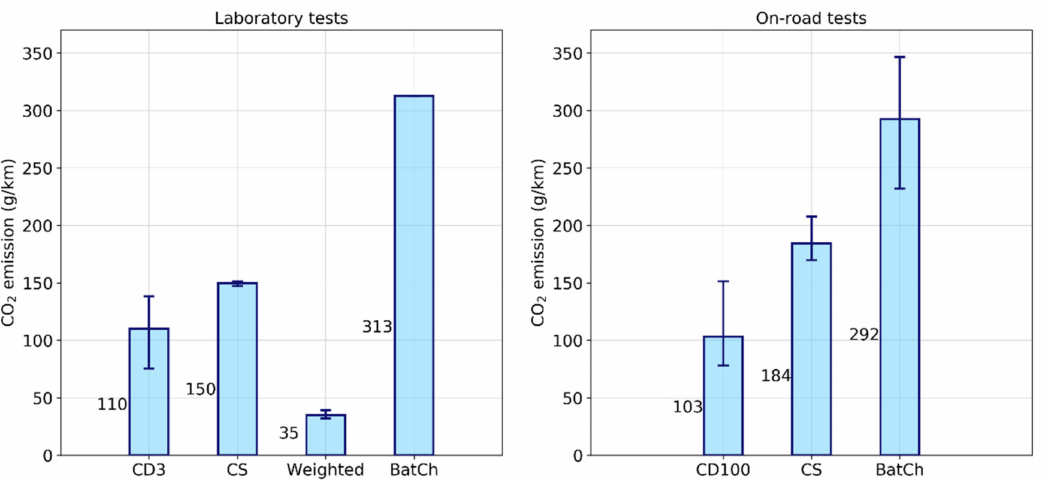
Figure 8. CO 2 emissions on laboratory ( left panel ) and on-road ( right panel ) tests performed according to the WLTP and RDE test procedures, respectively. CD100 and CS indicate tests with an initial state of charge (SOC) equal to 100% or the minimum, respectively. BatCh (battery charging) indicates the user-selectable mode of operation in which the internal combustion engine is used to charge the vehicle battery. Error bars on the graph represent maximum and minimum values. See the Methods section for additional